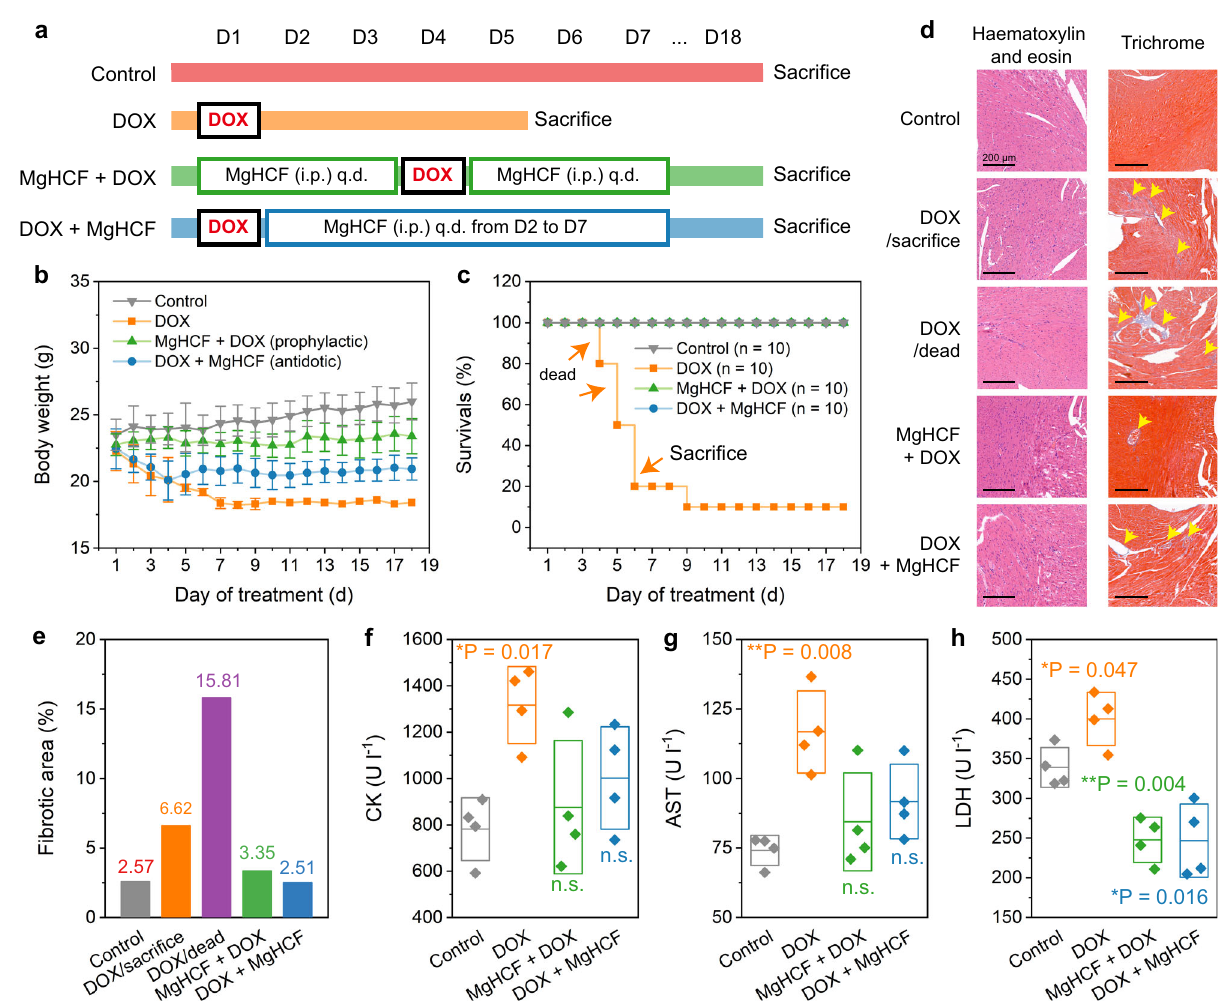
Fig. 6 | In vivo cardiac function evaluation. a Dosing schedule of the in vivo cardiac function evaluation. b , c Body weights ( b ) and survival rates ( c ) of mice from different groups during the evaluation period. n =10. Data are presented as mean±s.d. d H&E staining and Masson ’ s Trichrome staining images of the heart sections in different groups. e Impaired zone percentages on the heart tissue of